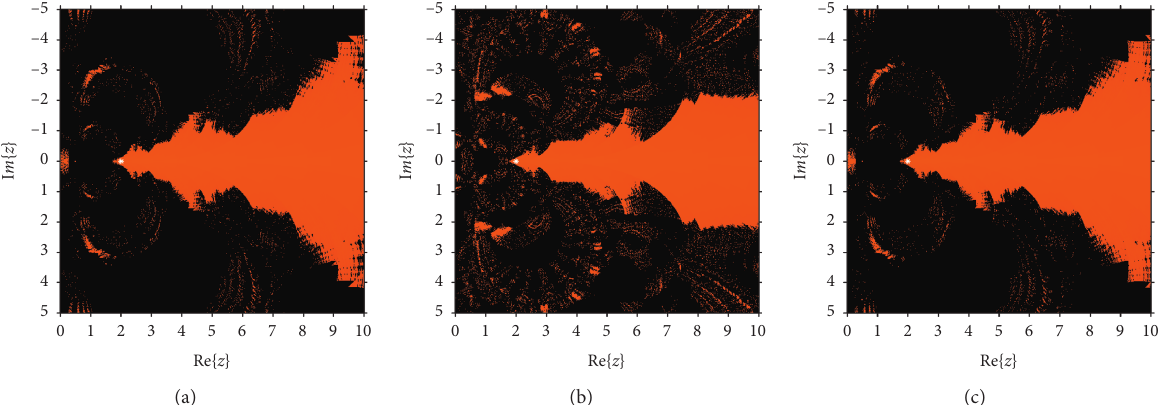
Figure 12: Basins of attraction of (a) SFM1, (b) SFM2, and (c) SFM3 for g